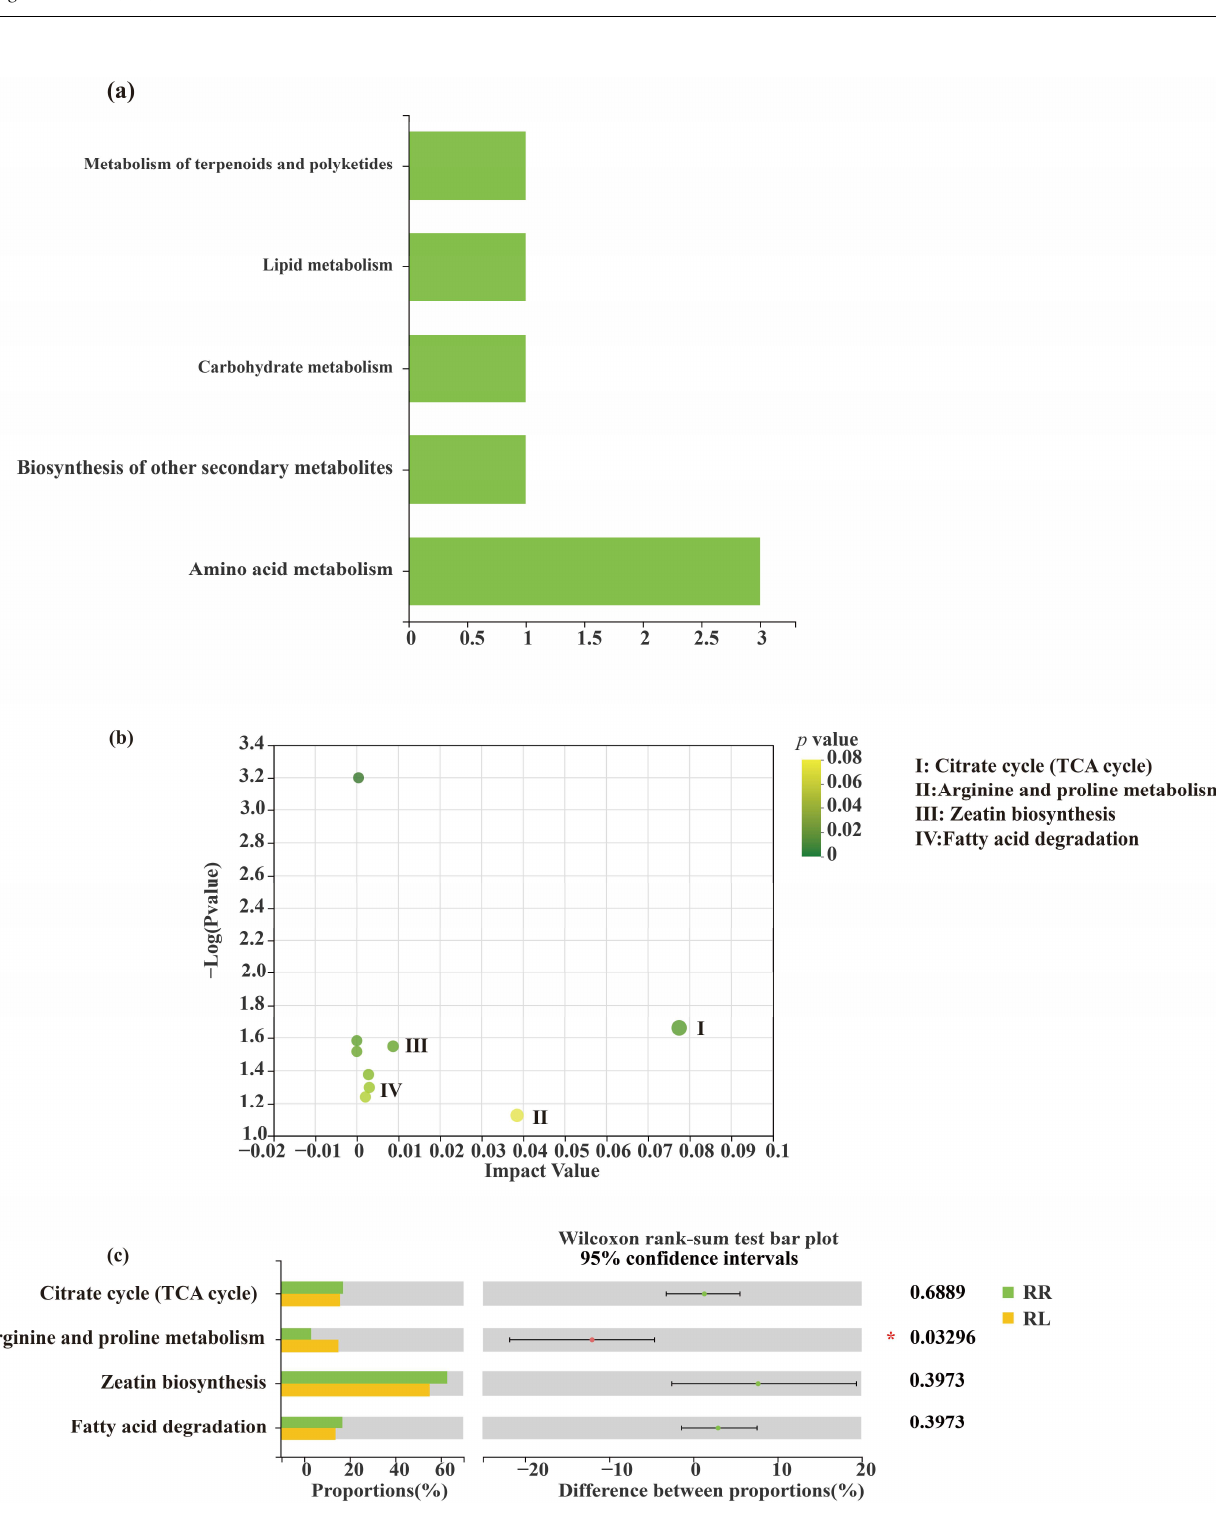
Figure 10. ( a ) KEGG pathway classification: metabolites detected and annotated. ( b ) Metabolic path- way enrichment study of differentially abundant metabolites between the oilseed rape monoculture (RR), intercropping system (RL). ( c ) The changes in root exudates in different metabolic pathways by KEGG. * The representation is significant. The correlation between the top 10 most abundant rhizospheric bacteria at genus level and metabolites was also analyzed using the Spearman correlation algorithm and the Bray–Curtis distance